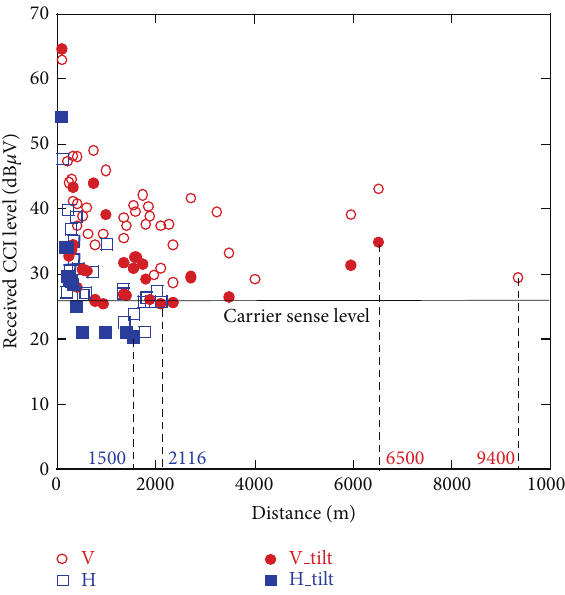
Figure 12: Received CCI level versus distance of